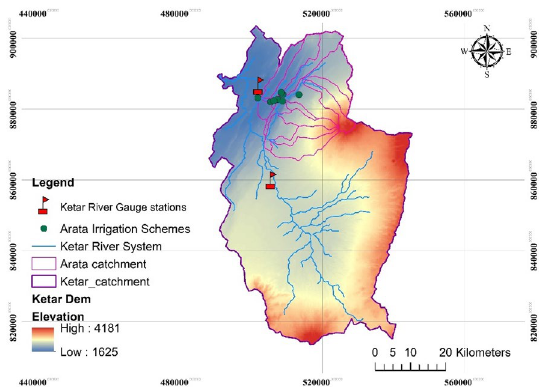
Fig. 2 Arata _ Ketar catchment, irrigation schemes, and river gauge stations